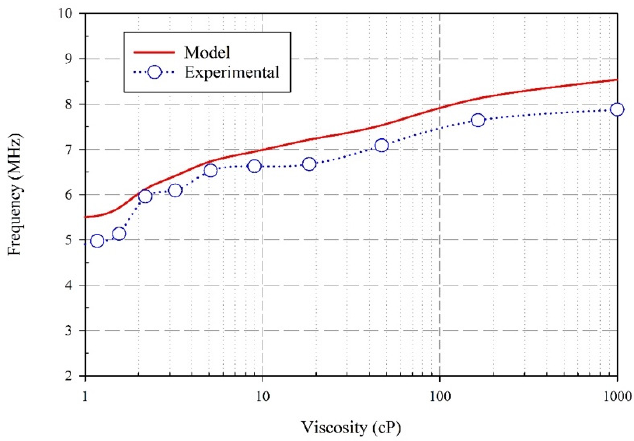
Figure 9. Variation of viscosity with resonant frequency for both experimental and modeled results.